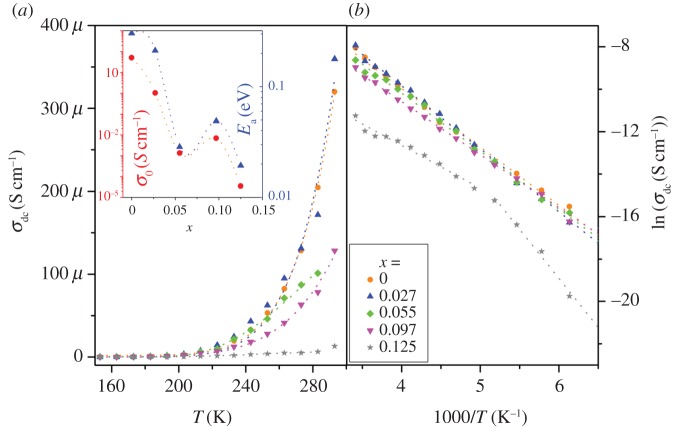
Temperature dependence of (a) DC conductivity, σdc versus T and (b) log(σdc) versus 1000/T for Cu1–xFexO (0 ≤ x ≤ 0.125). The dotted lines represent fitted spectra.